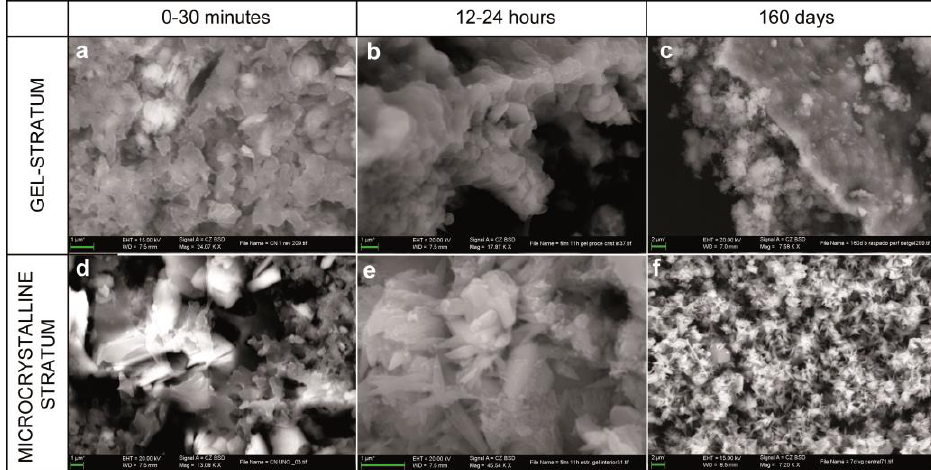
Figure 4. Evolution of texture developed in the gel-like stratum ( a – c ) and the microcrystalline stratum ( d – f ), both on the surface of a lime putty plaster. Images obtained by SEM. ( a ) Initial development of the gel-like stratum 30 min after application; ( b ) Growth of columnar structures on the inner side of the gel-like stratum 12–24 h after application; ( c ) Gel-like stratum after 160 days; ( d ) Initial development of microcrystalline interphase between the gel-like stratum and the surface of the slaked lime plaster; ( e ) Growth of various crystalline morphologies previously described by POM; ( f ) Advanced crystal development.